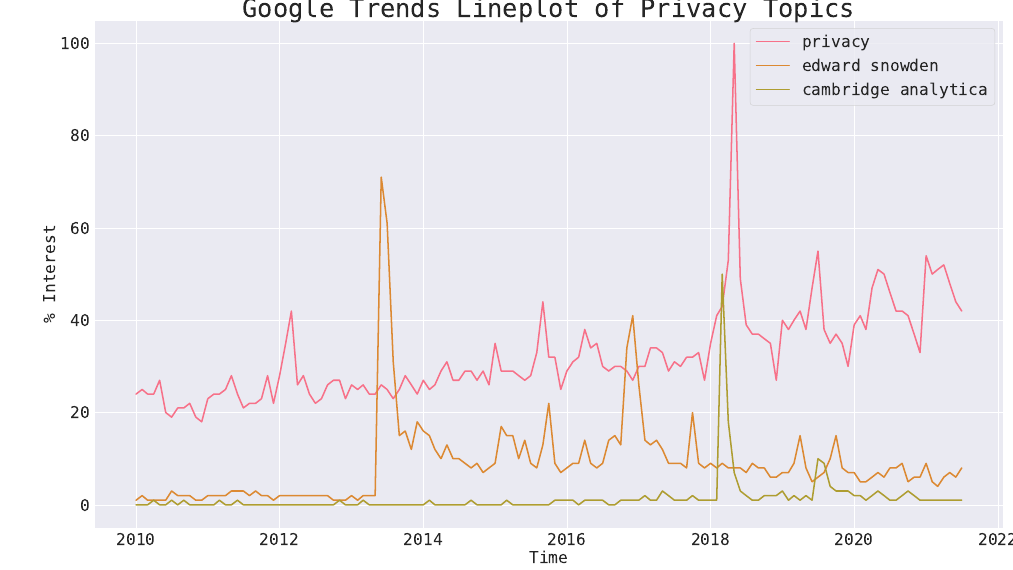
Figure 1. Trends of privacy (red), Edward Snowden (orange), and Cambridge Analytica topics (green) on Google trends since 2010 showing a slow but steady increase in the interest in privacy and particular peaks around events such as the Cambridge Analytica scandal and smaller peaks roughly correlated to Julian Assange